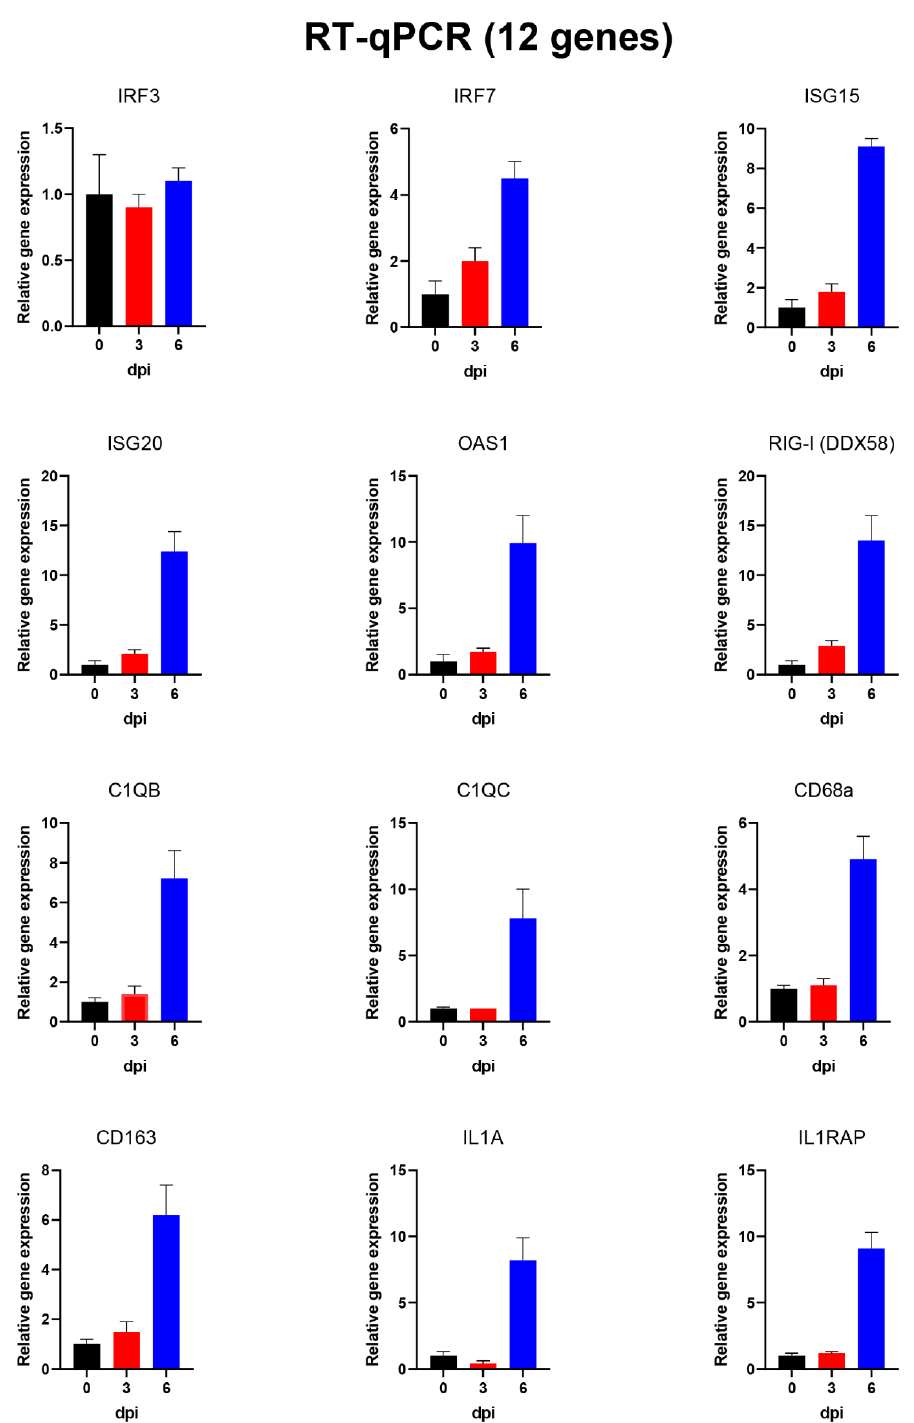
Figure 7. Expression of 12 selected host genes in PBMCs from ASFV-infected pigs. The relative expression levels (mean of 4 pigs +SEM) for these selected genes, as determined by qPCR assays, are shown for the PBMCs collected at 0, 3 and 6 dpi. All the genes (except for IRF3) were expressed at 4 – 12-fold higher levels at 6 dpi compared to 0 dpi.